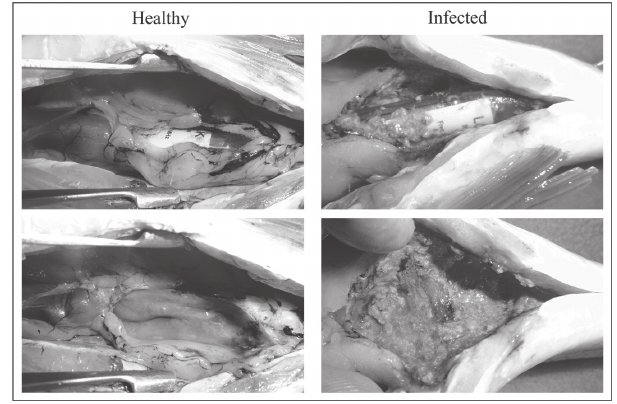
Fig. 3. Healthy (left) and infected (right) viscera on necropsy of Prochilodus lineatus